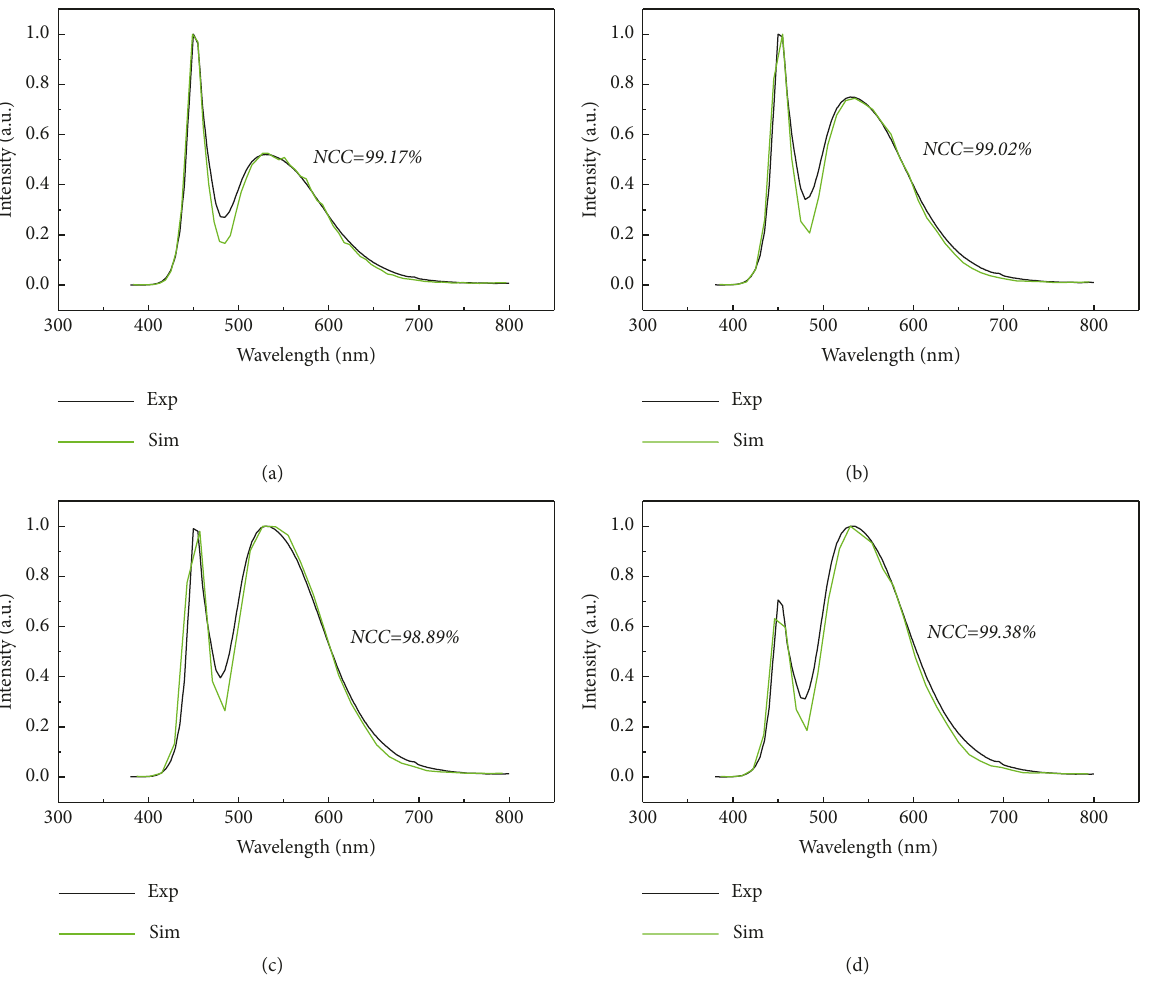
Figure 8: Spectrum power distribution of simulation and experiment at different mass ratio of green phosphor films (a) 0.4:1; (b) 0.5:1; (c) 0.6:1; (d) 0.7:1.